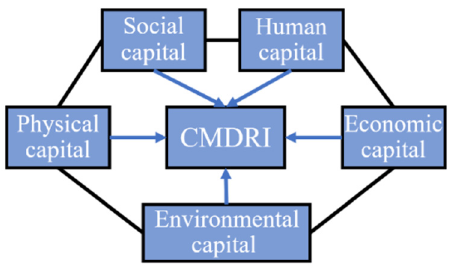
Figure 1. Conceptual framework for Coastal Marine Disaster Resilience Index (CMDRI) in China. Table 1. Dimensions and indicators of coastal marine disaster resilience.